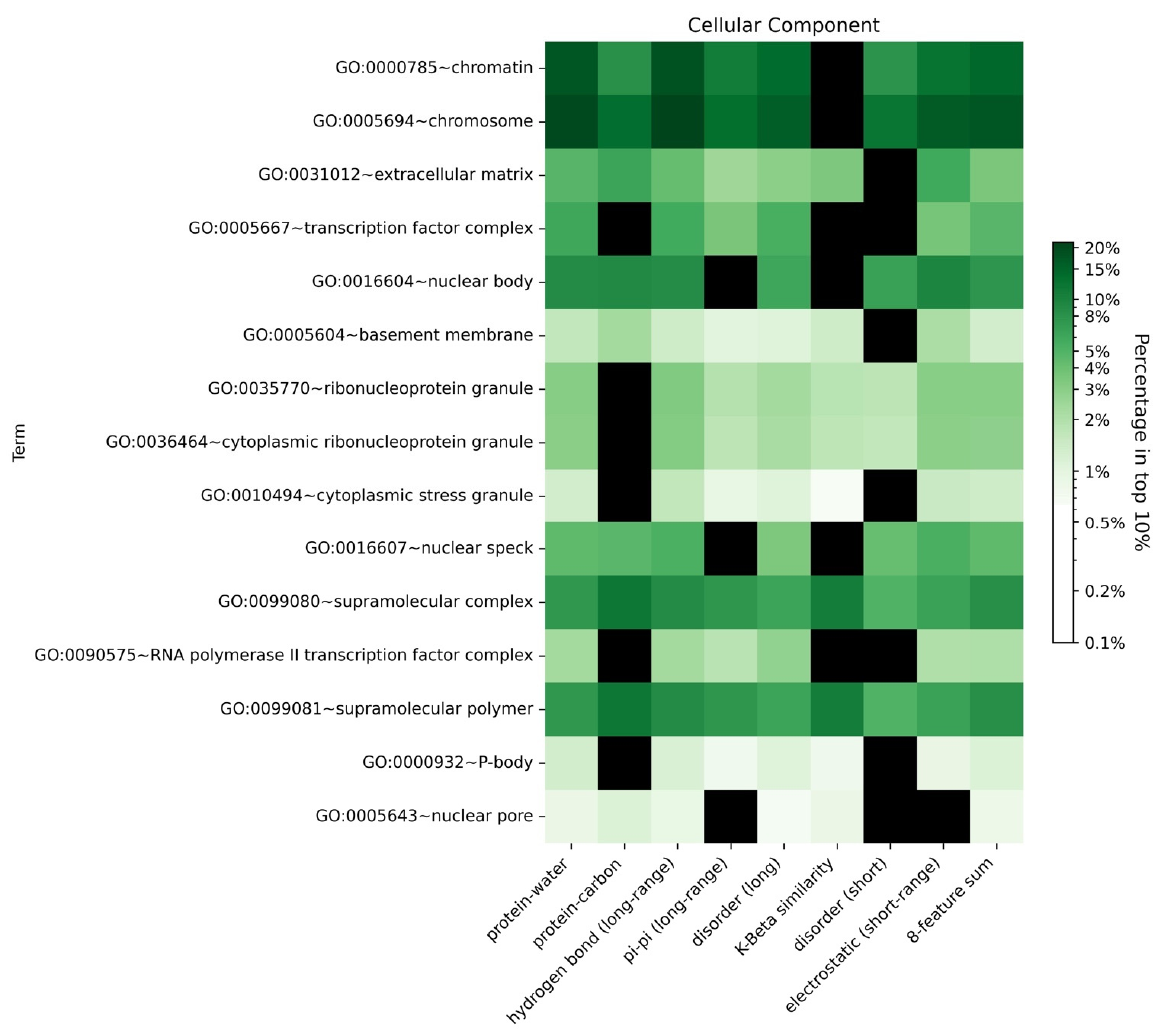
Figure 11. Enrichment heatmap by GO functional annotations for different features for the hu- man + PDB model. Heatmap showing the enrichment of the proteins with a given functional annotation that fall under a 10% confidence threshold for each single-feature score and the eight- feature sum score. The color gradient shows the natural logarithm of the enrichment percentage. The black boxes indicate that no proteins in this GO term are within the top 10% of the corresponding score